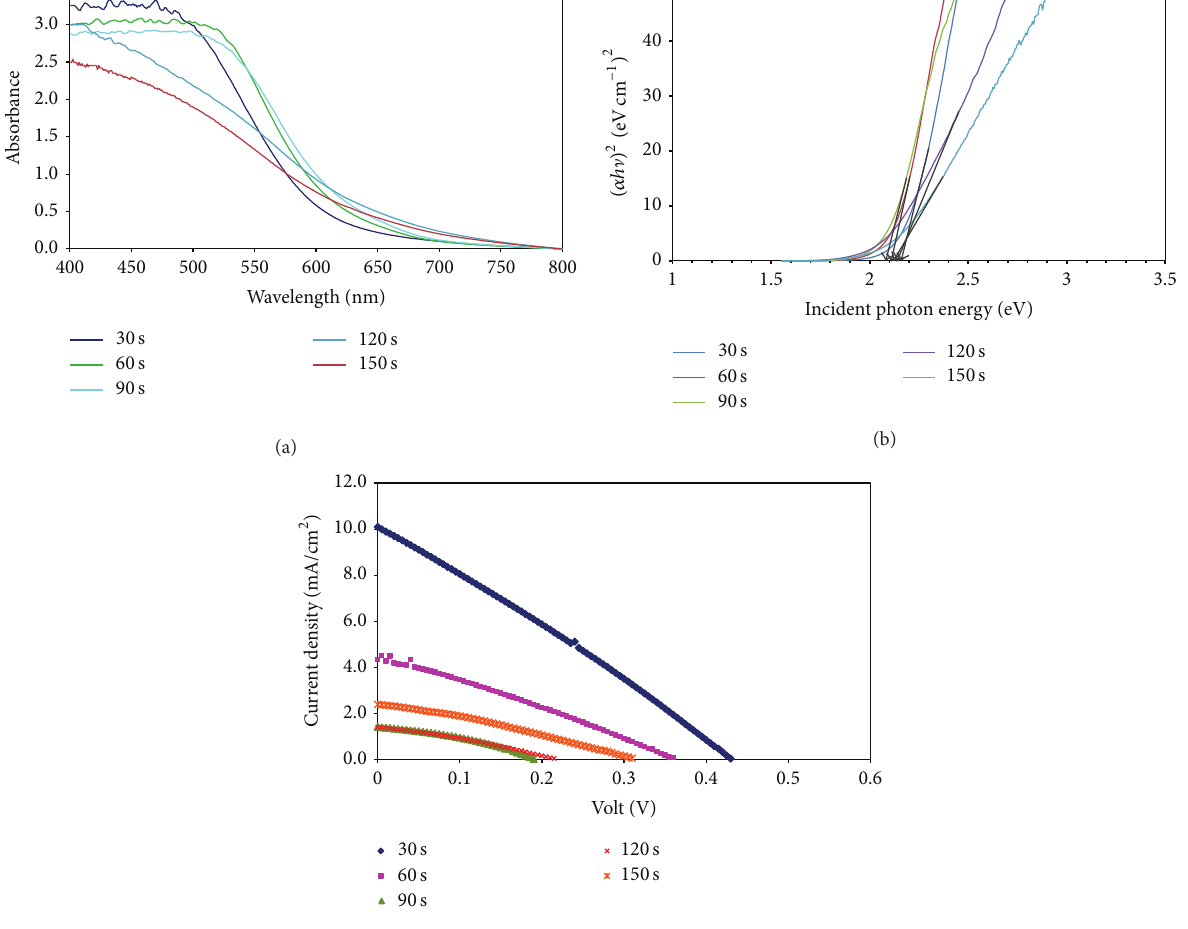
observed to be attached to the TiO 2 surface. In the